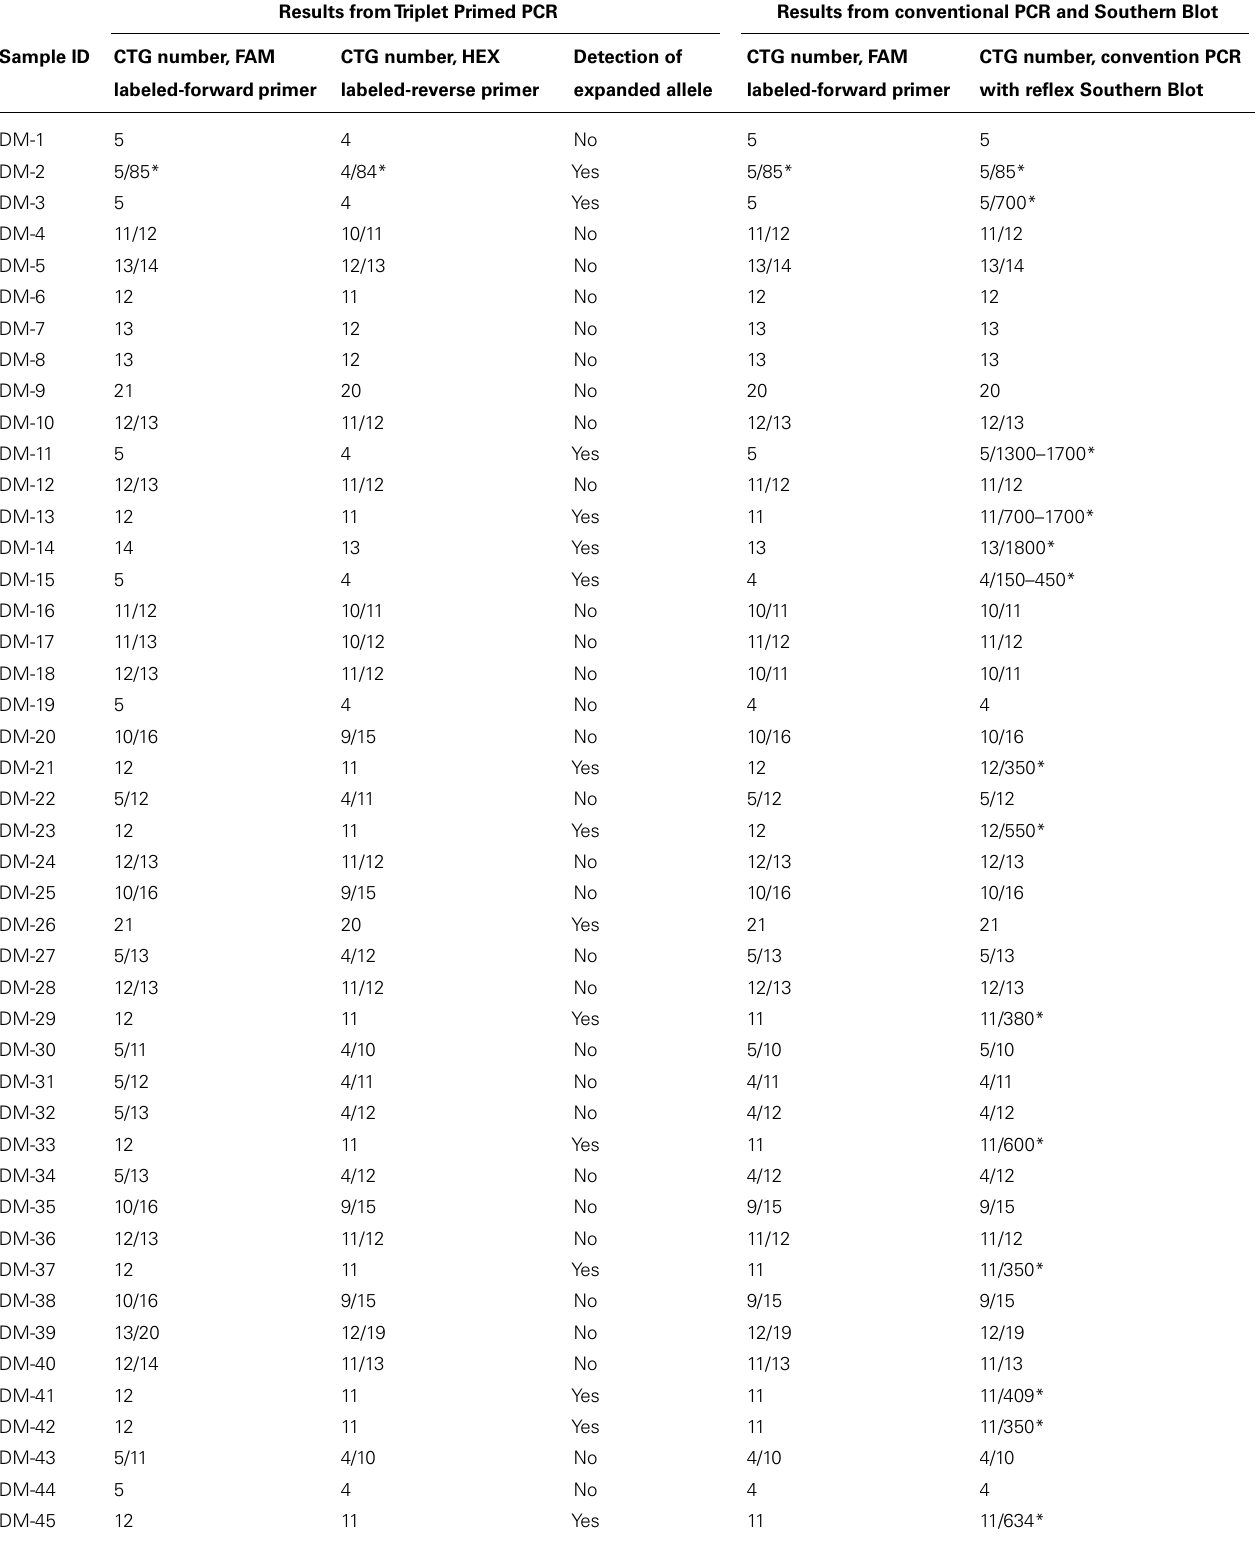
Table 2 | CTG size information obtained fromTriplet-repeat Primed PCR, conventional PCR and Southern Blot. Results fromTriplet Primed PCR Results from conventional PCR and Southern